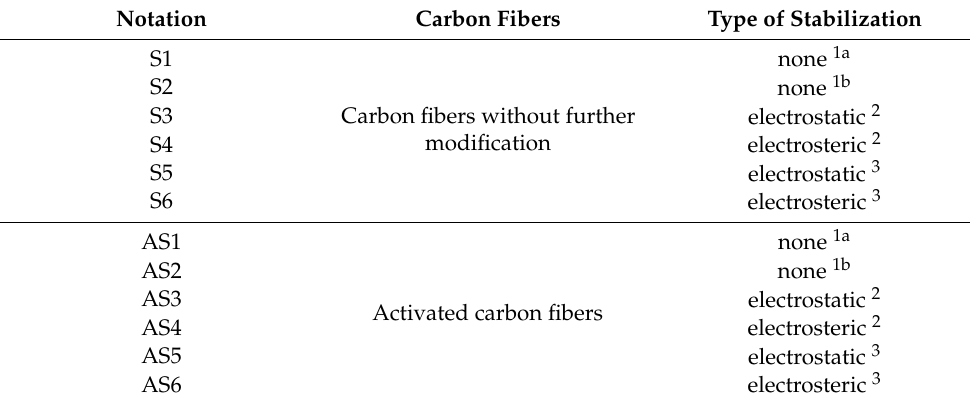
Table 1. Experimental conditions for the process of Au(III) ions and AuNP adsorption on carbon fibers (also activated) carried out in the batch reactor. Conditions: C 0, Au(III) = 0.3 mM, C 0, H2Asc = 0.6 mM, addition of PVA (mass ratio of Au(III) to polymer equals 1:10), amount of the carbon/ activated carbon fibers 0.025 g/25 mL of the solution, T = 20 ◦ C.